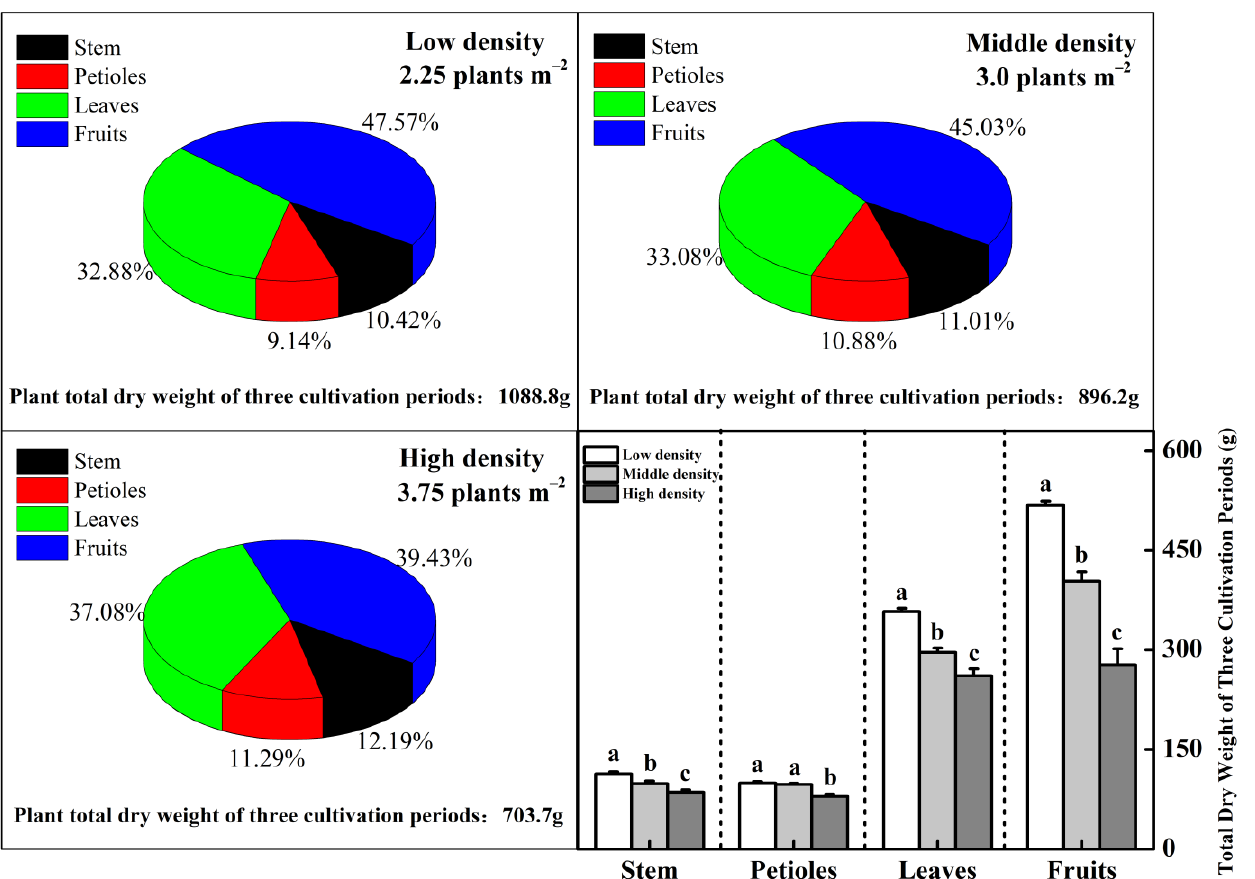
Figure 6. Cucumber plant dry matter distribution of different density treatments in three cultivation periods. The data represent the mean ± SD (n = 3). Different letters indicate significant differences at α = 0.05 based on the Least Significant Difference (LSD) test.